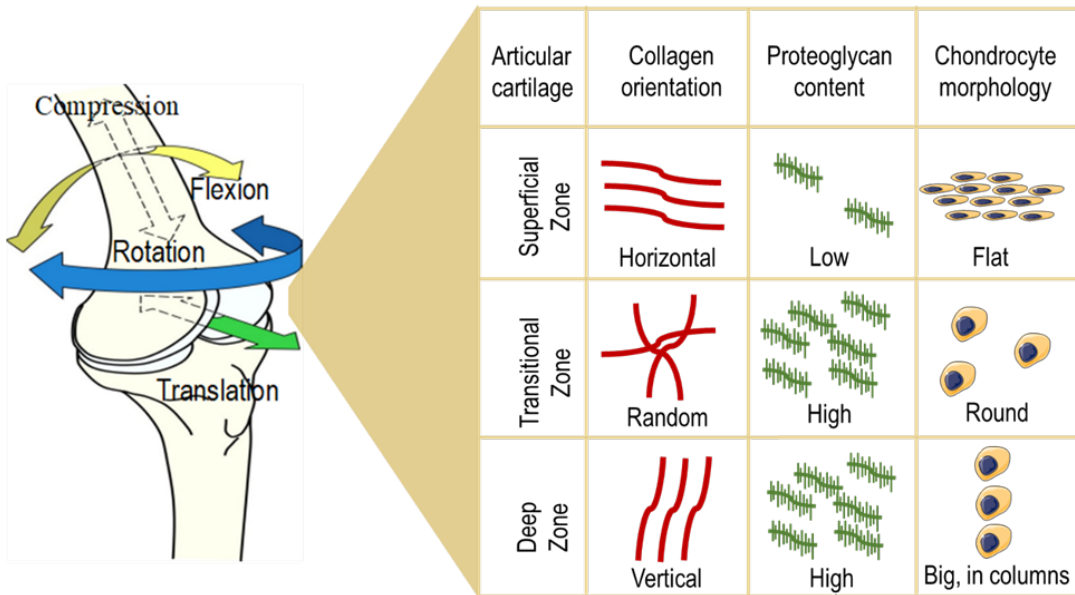
Figure 1. Structure of the articular cartilage. The structure of the articular cartilage comprises several layers: First, a superficial zone, where the collagen fibers are aligned horizontally, the chondrocytes are numerous and flattened, and the proteoglycan content is low. Under the first zone, there is a